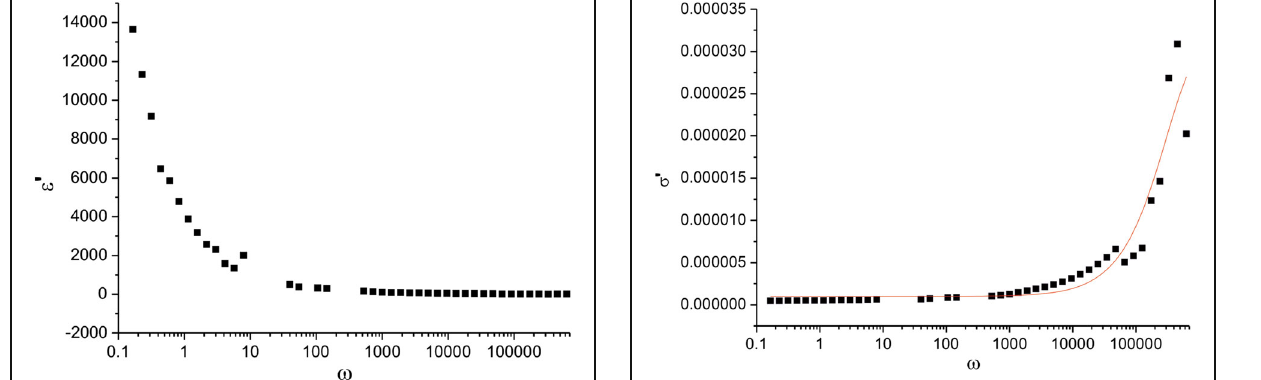
Fig. 8 Dependence of real part of dielectric constant from the frequency at 273 K